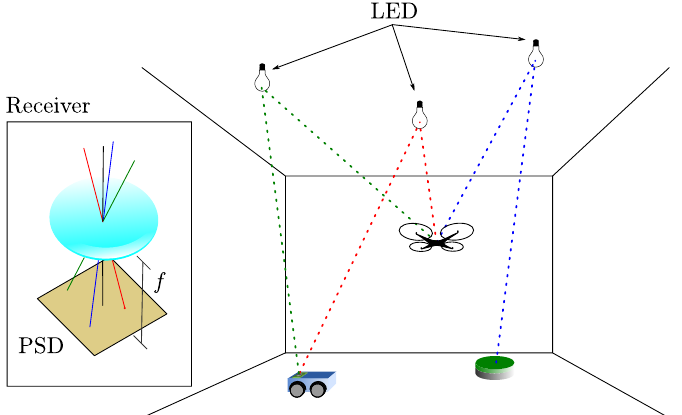
Figure 1. Diagram of the proposed positioning system based on optical AoA measurements with a PSD